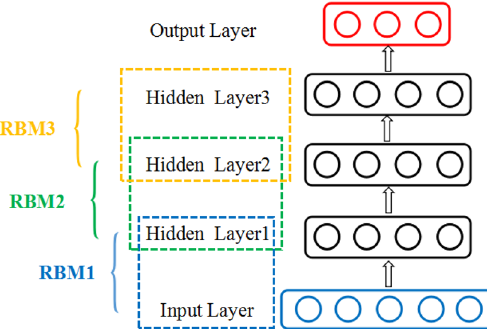
Figure 2. Three-layer DBN